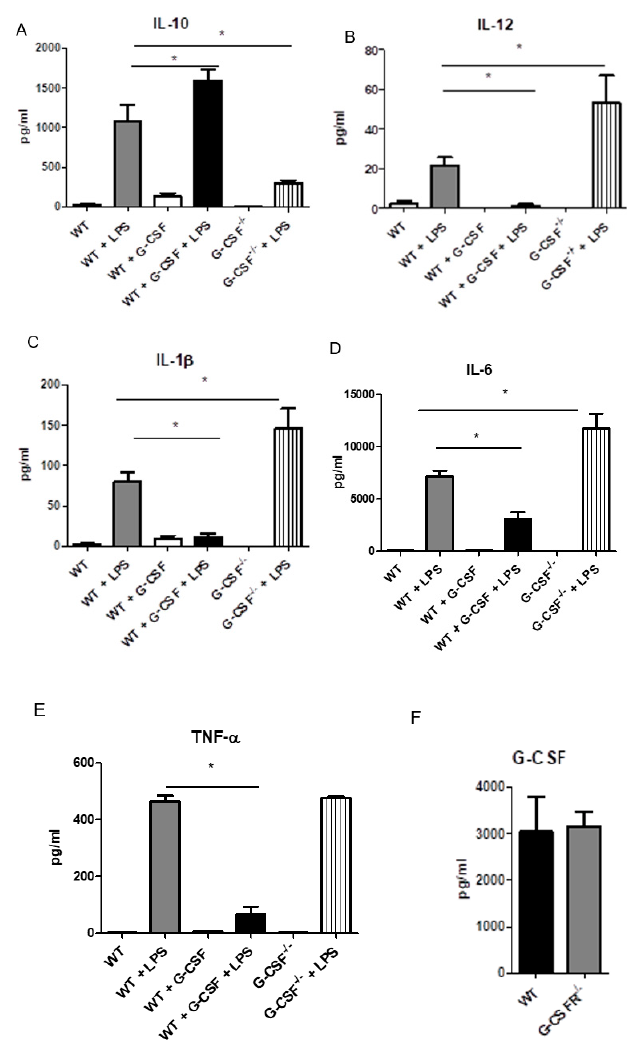
Figure 2. WT, G-CSFR − / − or WT + G-CSF BMM activated by LPS produce different patterns of cytokines by multiplex array analysis of ( A ) IL-10 ( B ) IL-12, ( C ) IL1 β ( D ), IL-6 and ( E ) TNF- α and ( F ) G-CSF, n = 8, * p ≤ 0.05.